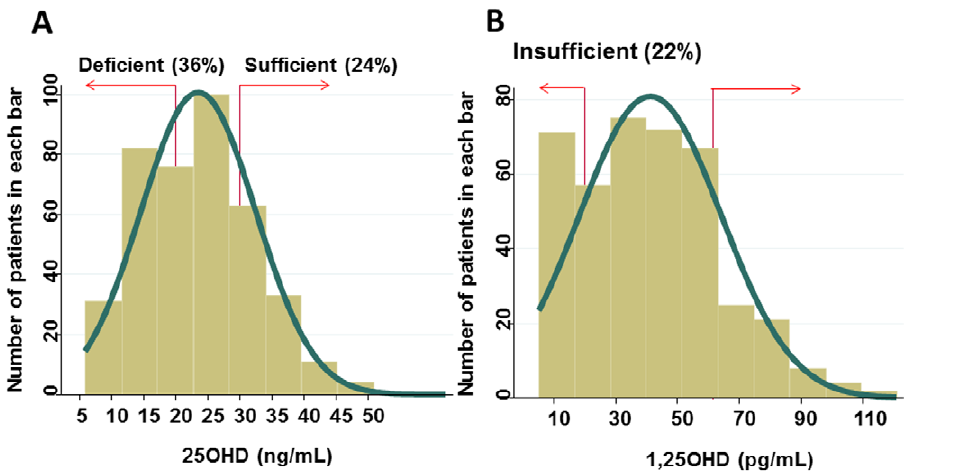
Figure 1. Histogram of circulating 25OHD levels (A) and 1, 25OHD levels (B) in patients with type 2 diabetes and with CKD stage 1 , 5. Blood sampling was performed at entry; thus disease duration differed among patients. Serum 25OHD and 1,25OHD were measured by radioimmunoassay. doi:10.1371/journal.pone.0051171.g001 PLOS ONE |